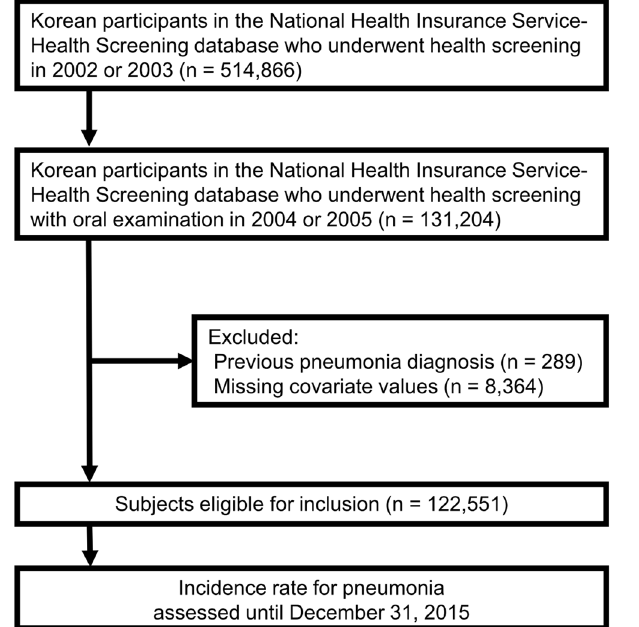
Figure 1. Flow of study